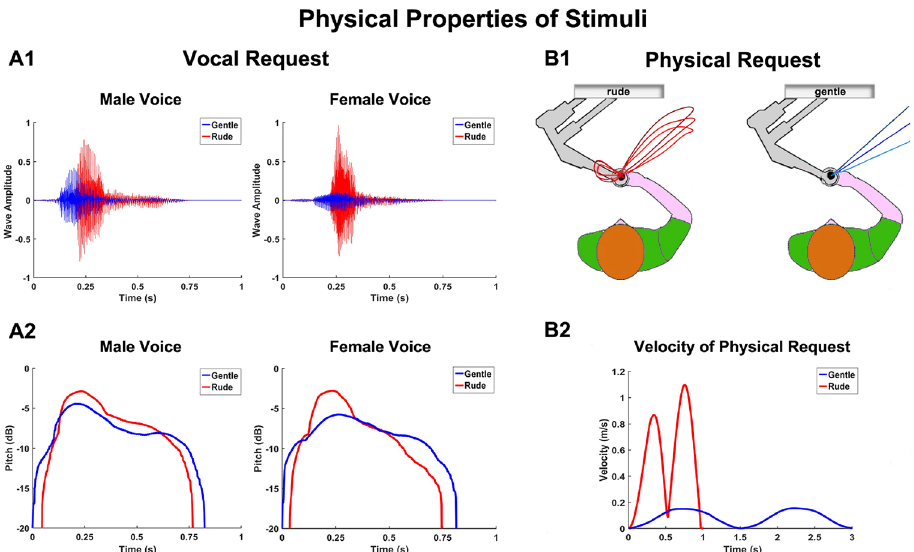
Figure 3. Physical properties of stimuli. Wave amplitude ( A1 ) and pitch ( A2 ) of rude (red) and gentle (blue) vocal requests for the male and the female voice. Spatial trajectories of the motions performed by the manipulandum to provide rude (red lines) or gentle (blue lines) physical requests ( B1 ). Velocity module of rude (red line) and gentle (blue line) physical requests ( B2